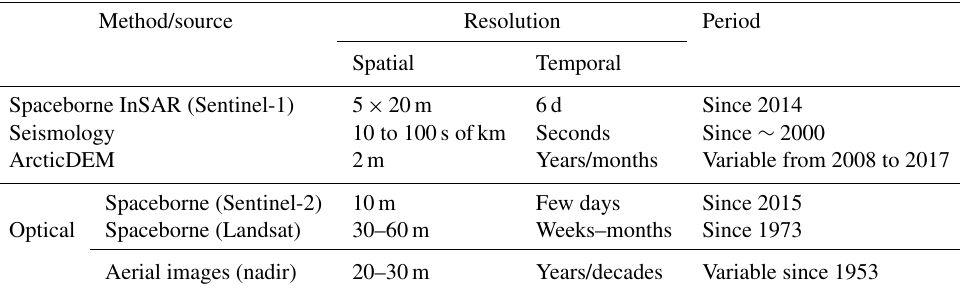
Table 1. Temporal and spatial resolution of the various